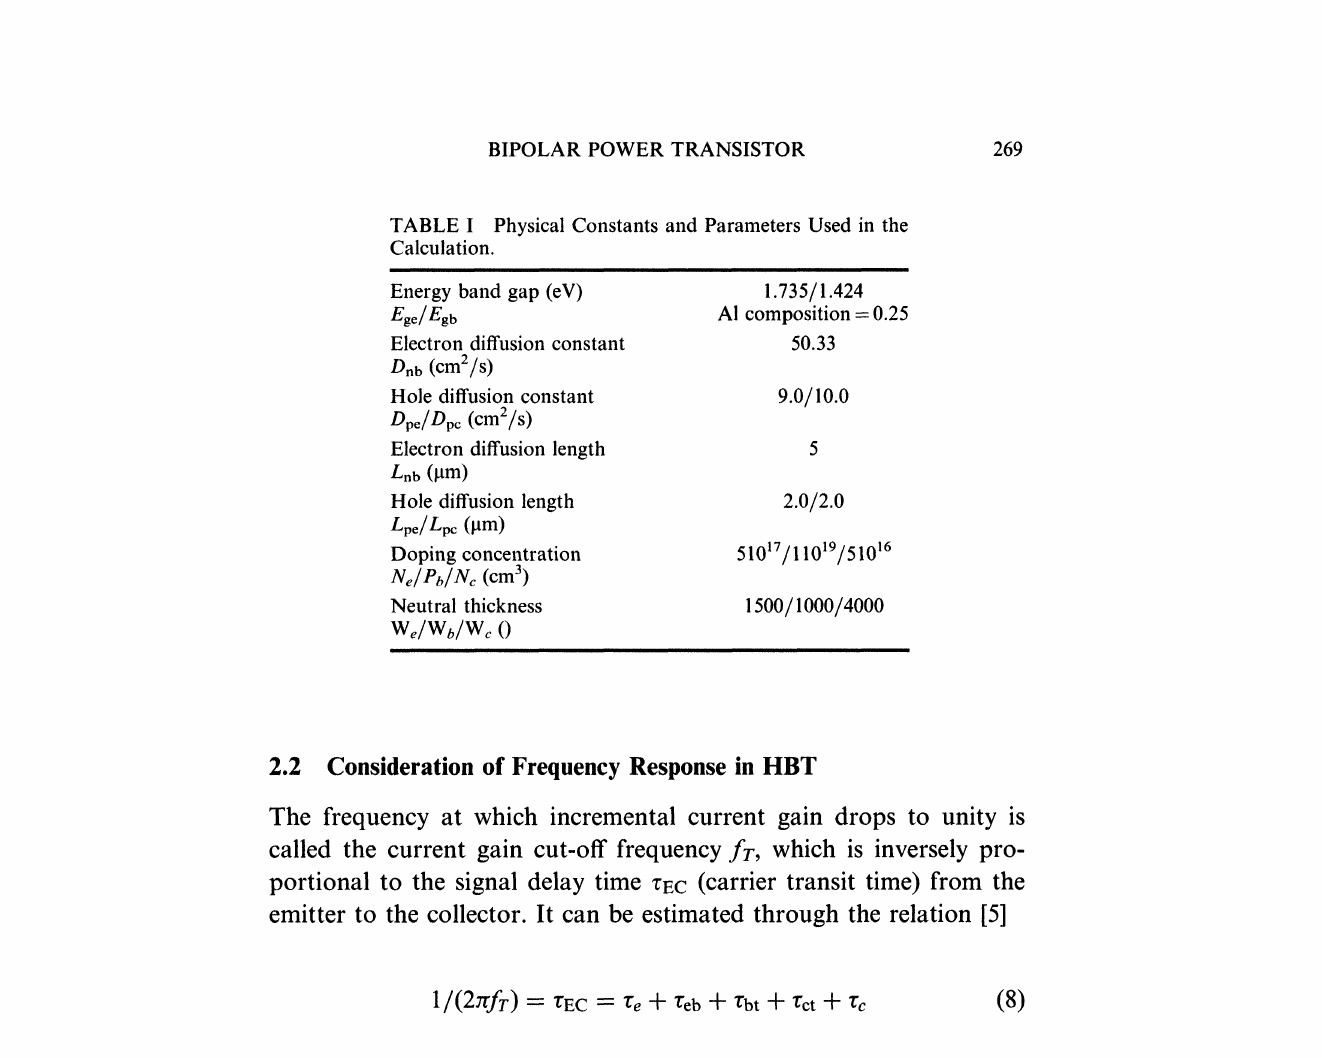
Physical Constants and Parameters Used in the